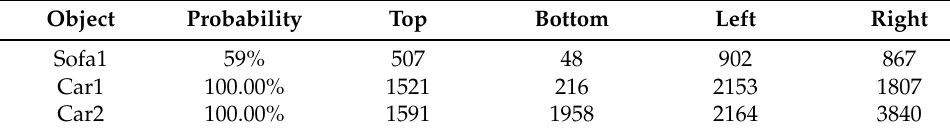
Table 3. Probability and location of object recognition.